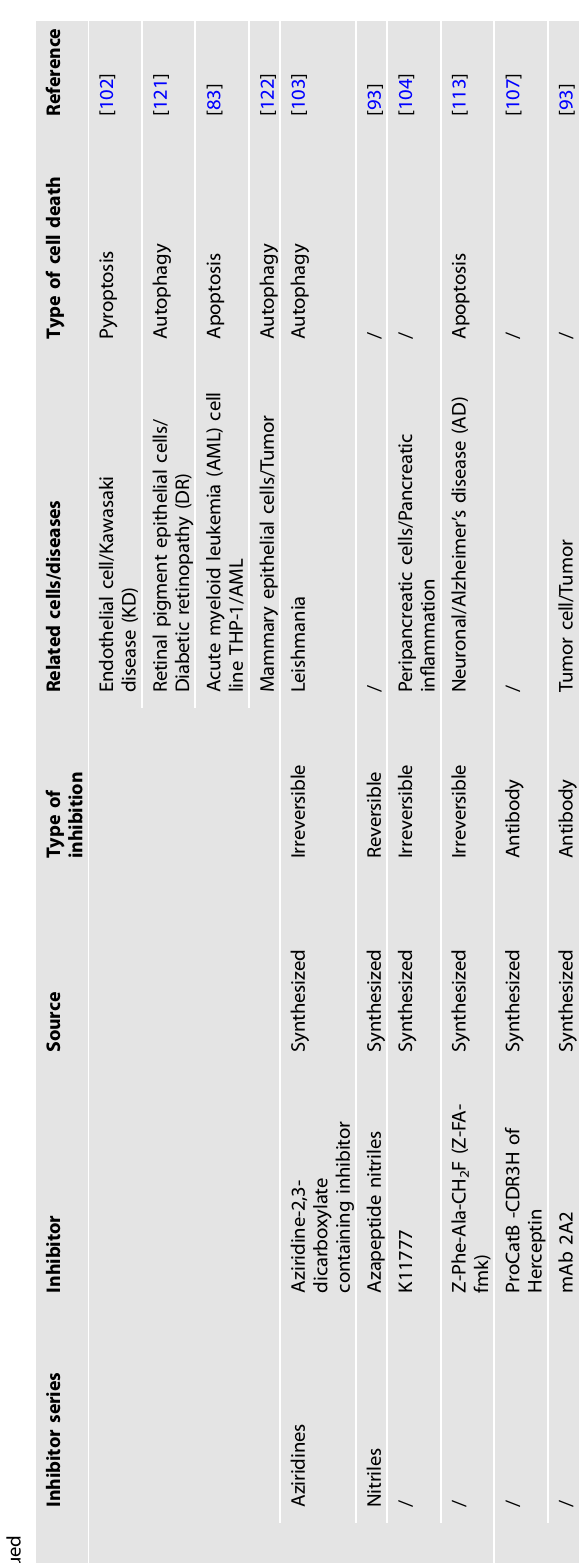
neonatal-onset multisystem in fl ammatory disease [75, 76], kawa- saki disease [102] and acute myeloid leukemia [83]. Except for the most common epoxysuccinyl inhibitors, aziridine-2,3-dicarboxy- late containing inhibitor can induce cell death in Leishmania [103], K11777 is able to improve pain in pancreatic in fl ammation [104]. Epoxysuccinyl inhibitors are the most studied class of irrever- sible CatB inhibitors. However, the irreversibility and possible side effects limit their clinical application, which led to the develop- ment of reversible inhibitors [93]. A focused library of derivatives of nitroxoline has been reported, which is a potent, selective and reversible CatB inhibitor can alleviate tumor cell invasion [105].